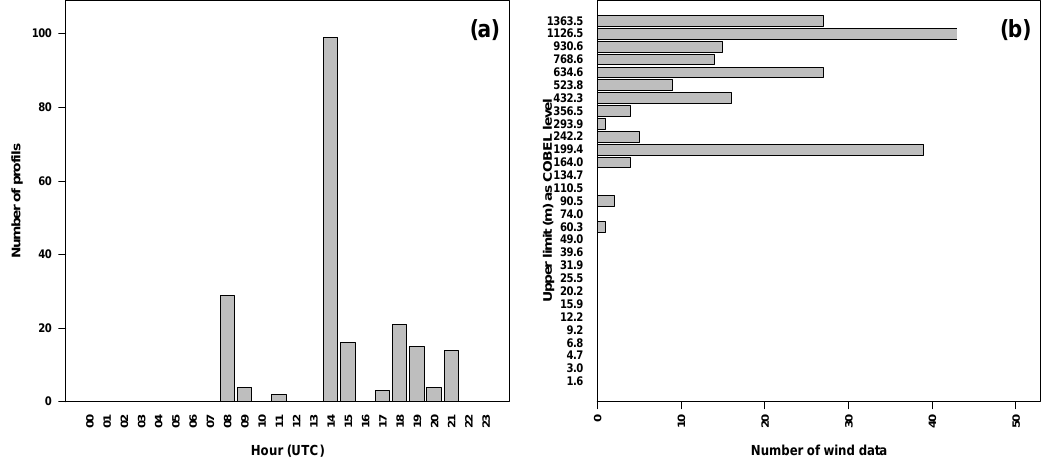
Figure 1. Statistics of wind AMDAR frequency within a radius of 30 km around Nouasseur international airport and below 1360 m (top of the COBEL-ISBA model) over the winter period (December 2015–February 2016): ( a ) Hourly frequency, and ( b ) Vertical frequency as function of COBEL-ISBA